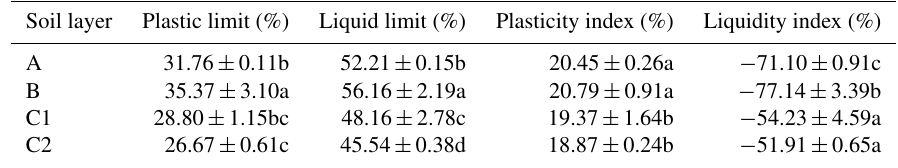
Table 5. Soil Atterberg limits of different weathering profiles of the Quaternary red clay in Xianning.